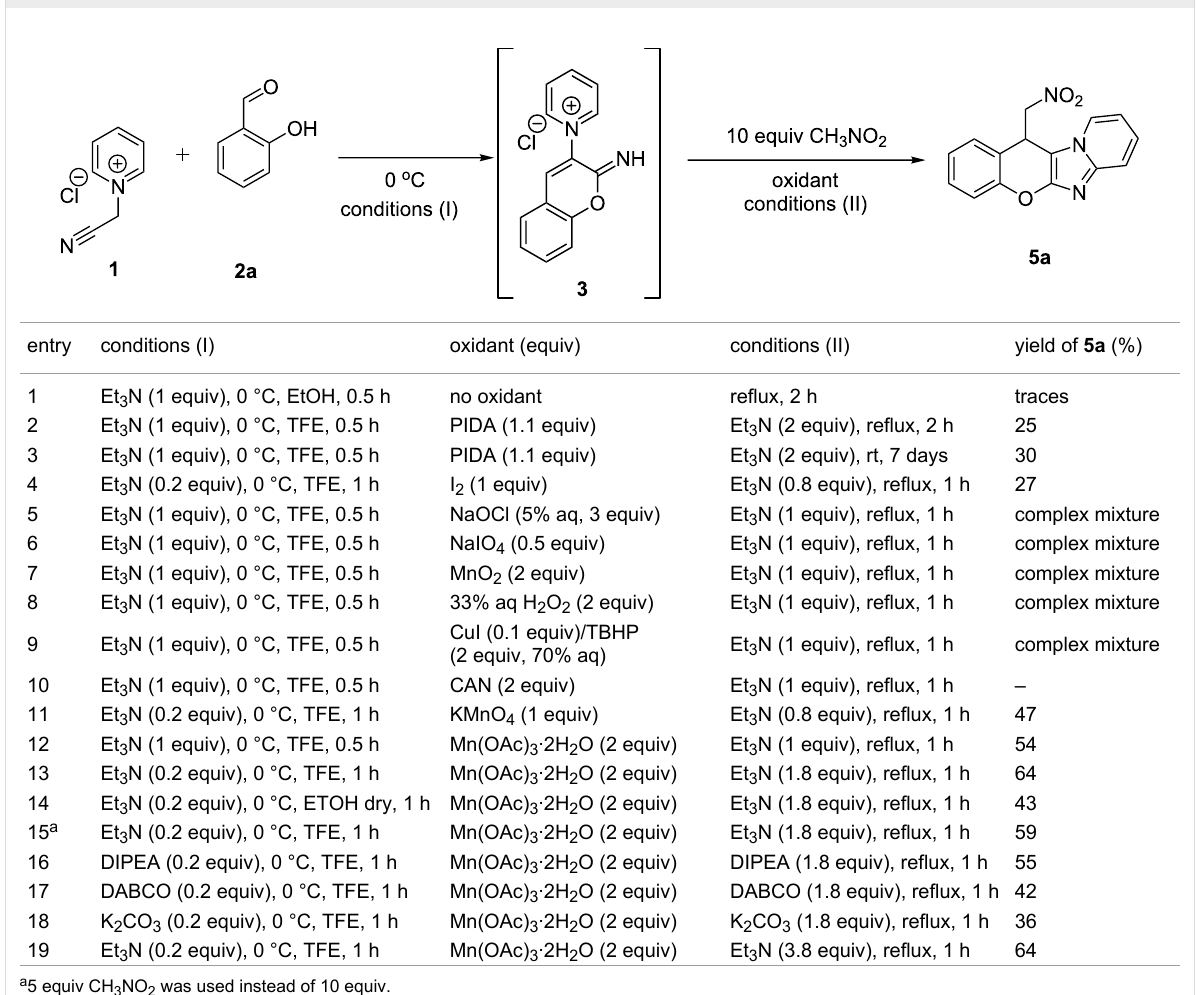
Table 1: Optimization of reaction conditions with nitromethane